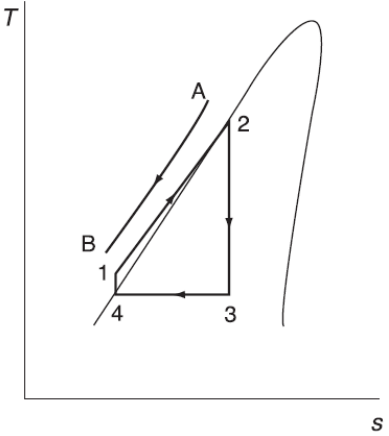
Figure 6. T – s diagram of the trilateral flash cycle [25].